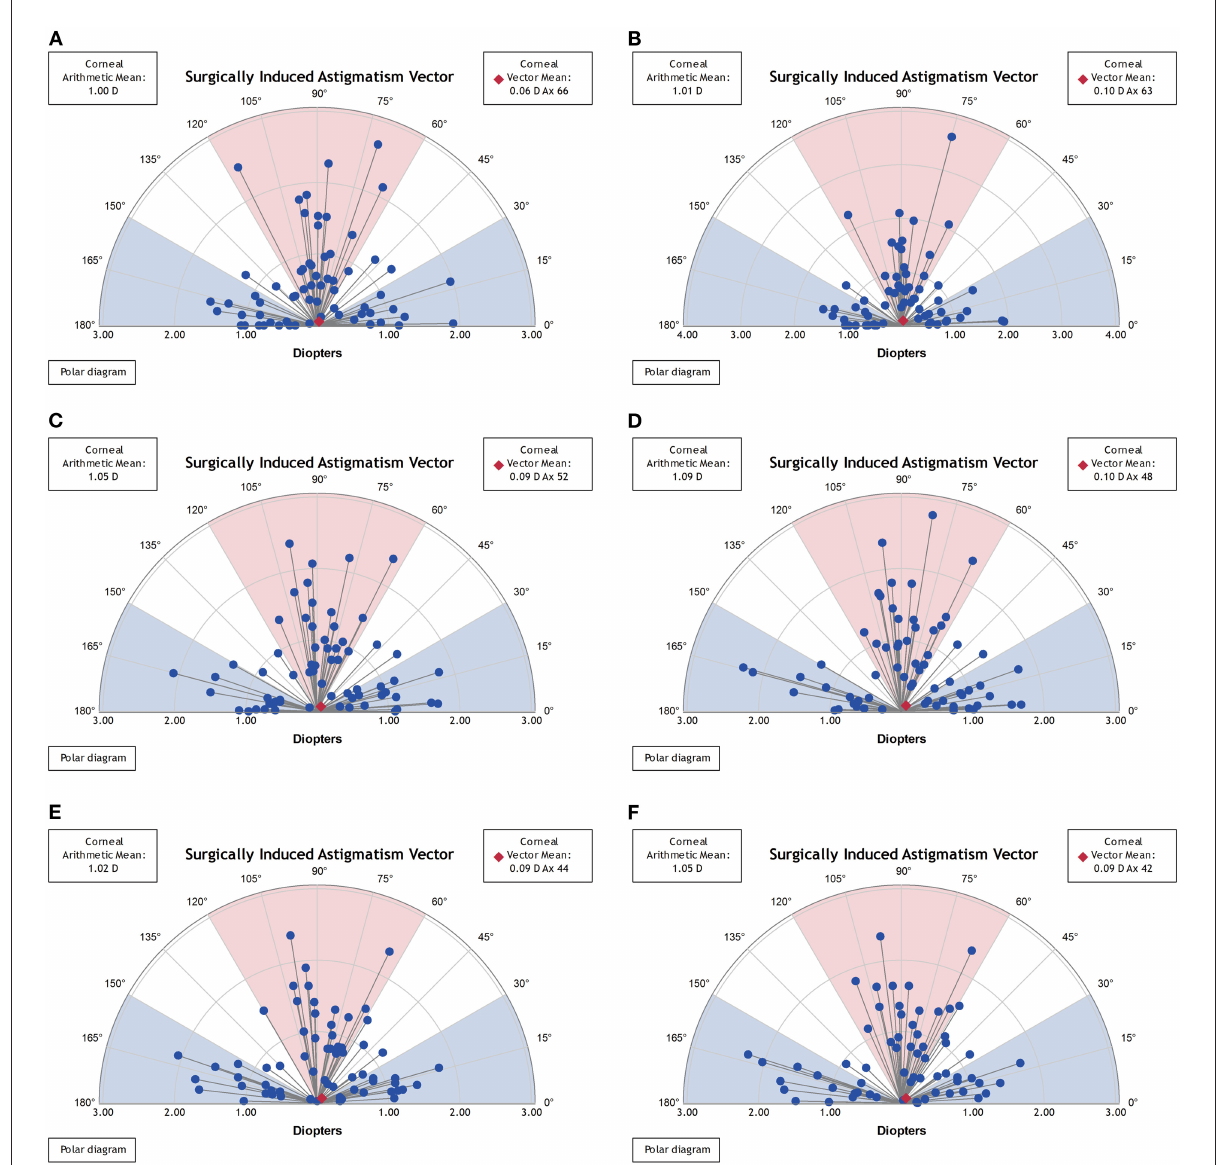
FIGURE6 Vector analysis of postoperative real and synthetic SIA in the 1-mm, 3-mm, and 5-mm zones. (A) The real postoperative SIA of the 1-mm zone. (B) The synthetic postoperative SIA of the 1-mm zone. (C) The real postoperative SIA of the 3-mm zone. (D) The synthetic postoperative SIA of the 3-mm zone. (E) The real postoperative SIA of the 5-mm zone. (F) The synthetic postoperative SIA of the 5-mm